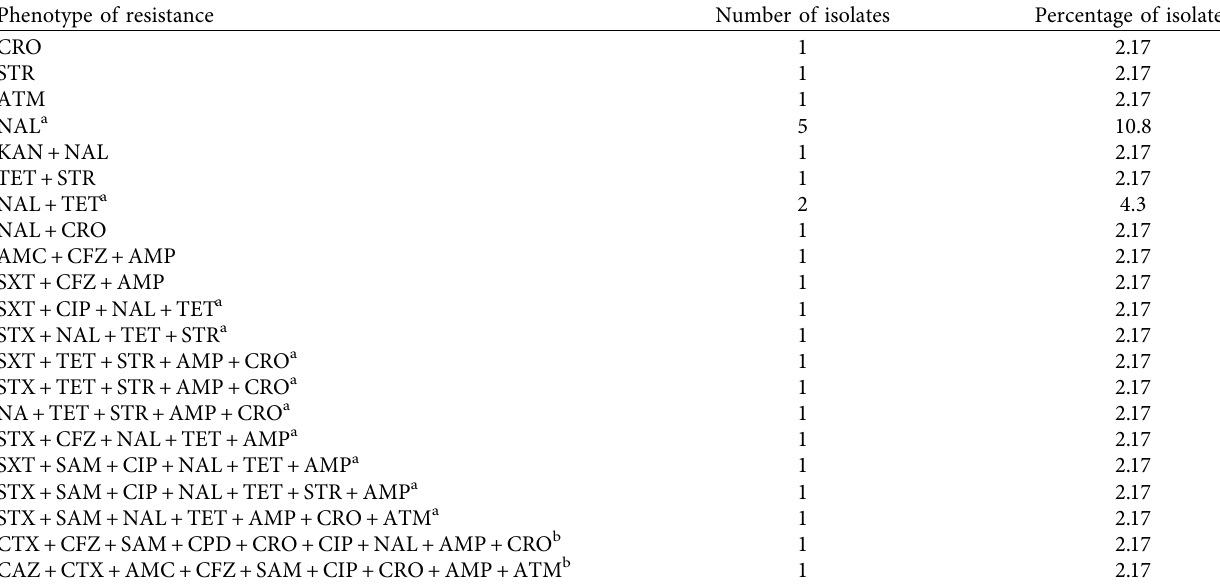
Table 2: Phenotypes of resistance detected among the E. coli isolates recovered from pets. Phenotype of